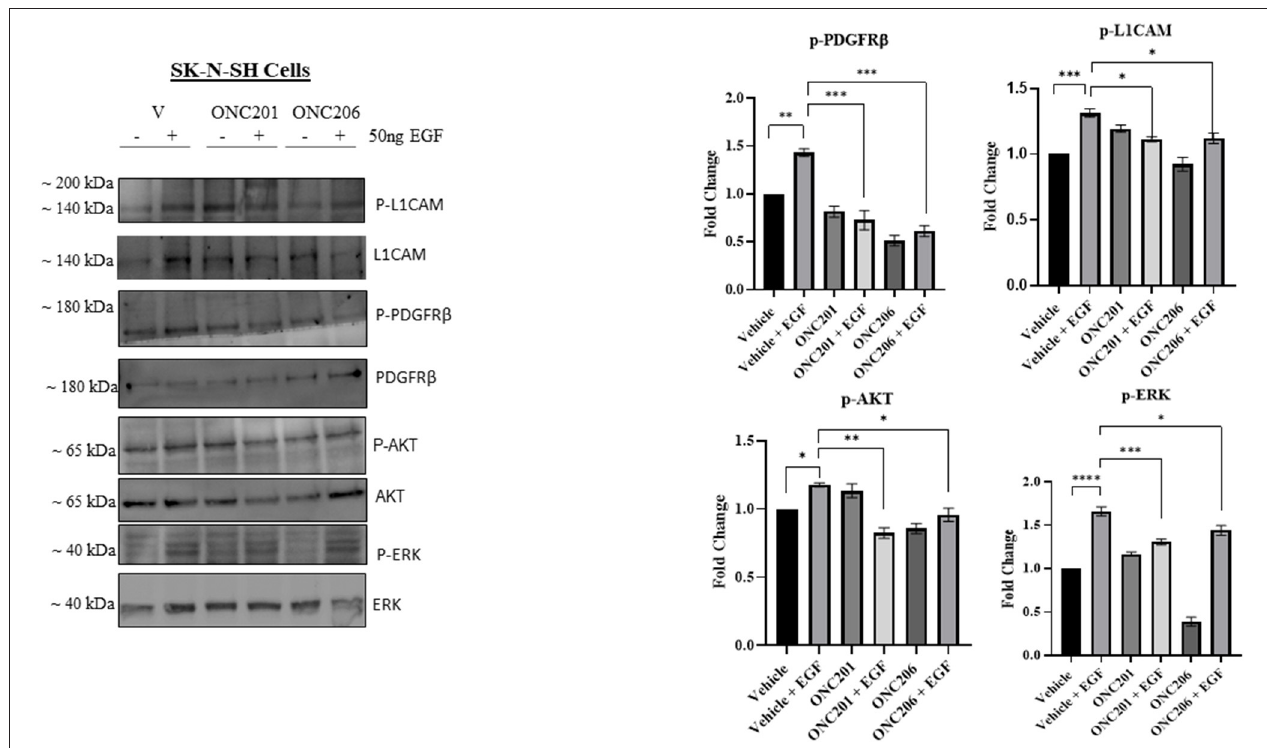
FIGURE 8 | ONC201/ONC206 treatment induces differential expression of tumorigenic proteins in SK-N-SH cells. EGF-induced phosphorylation of L1-CAM, PDGFR β , and AKT/ERK was significantly reduced with a single continuous dose of either ONC201 (5 µ M) or ONC206 (0.5 µ M) treatment compared with vehicle-treated cells. Experiments were conducted in triplicates and repeated three times. Data represent the mean ± the standard error of the mean (SEM) of multiple experiments. * p < 0.05; ** p < 0.01; *** p < 0.001; **** p <